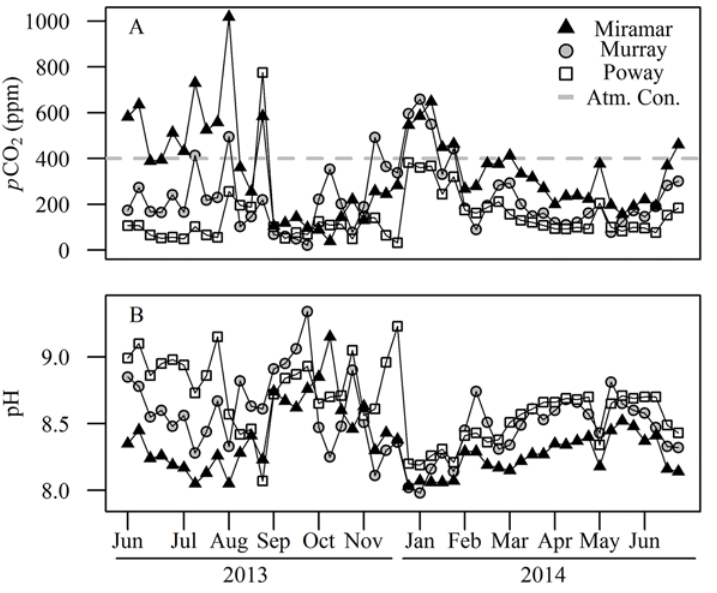
Fig 2. pCO2 and pH time series. (A) Time series of partial pressure of carbon dioxide (pCO 2 ) in ppm for each of the three reservoirs. Current atmospheric concentrations of pCO 2 are ~400ppm. (B) pH for each reservoir for 50 sampling weeks. Symbols indicate the reservoir as shown in the